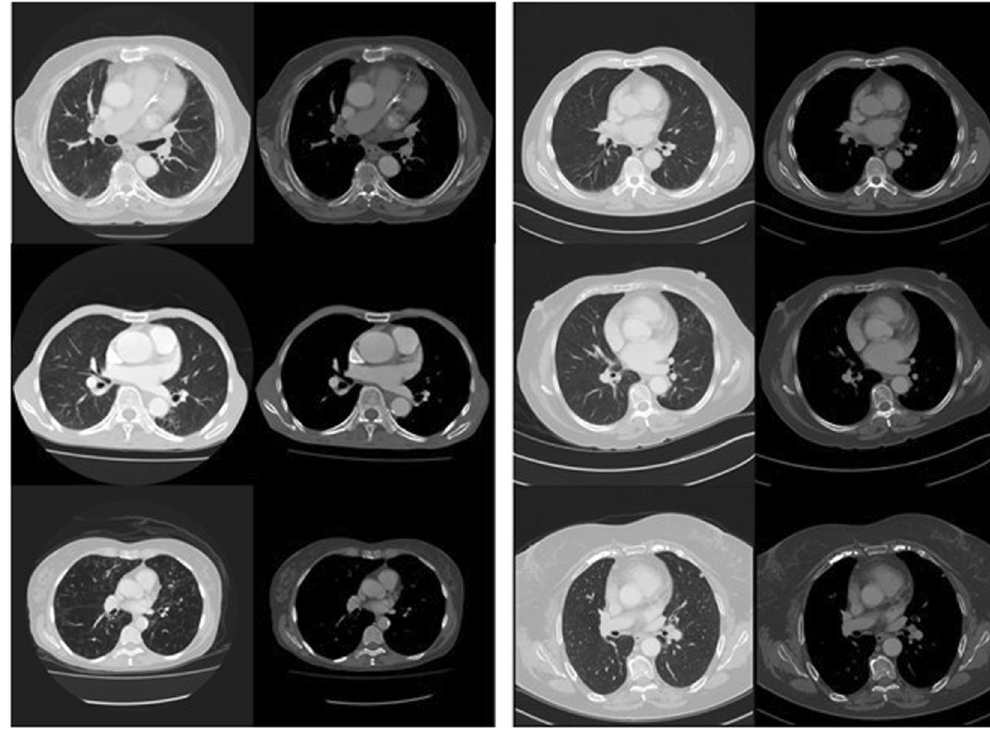
Figure 4. Images at the level of the proximal left anterior descending coronary artery, with the most strongly predicted mortality and survival cases selected by averaging the predictions from the deep learning and engineered feature models. The mortality cases (left side) demonstrate prominent visual changes of emphysema, cardiomegaly, vascular disease and osteopaenia. The survival cases (right side) appear visually less diseased and